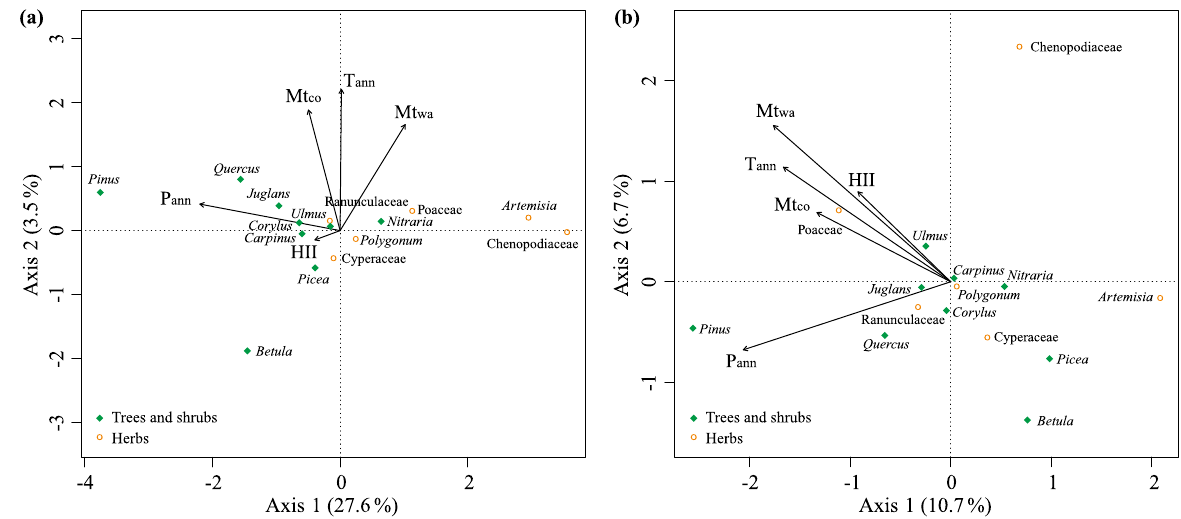
Figure 3. Ordination results of redundancy analysis (RDA) for 15 major pollen taxa with climate variables ( P ann , T ann , Mt co , and Mt wa ) and human influence index (HII) for (a) the natural set and (b) the human-induced